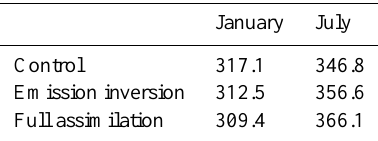
Table 9. The 1-day average (on the 19th of each month in 2007) global tropospheric O 3 burden (TgO 3 ) obtained from the control run, the emission inversion run, and the full data assimilation